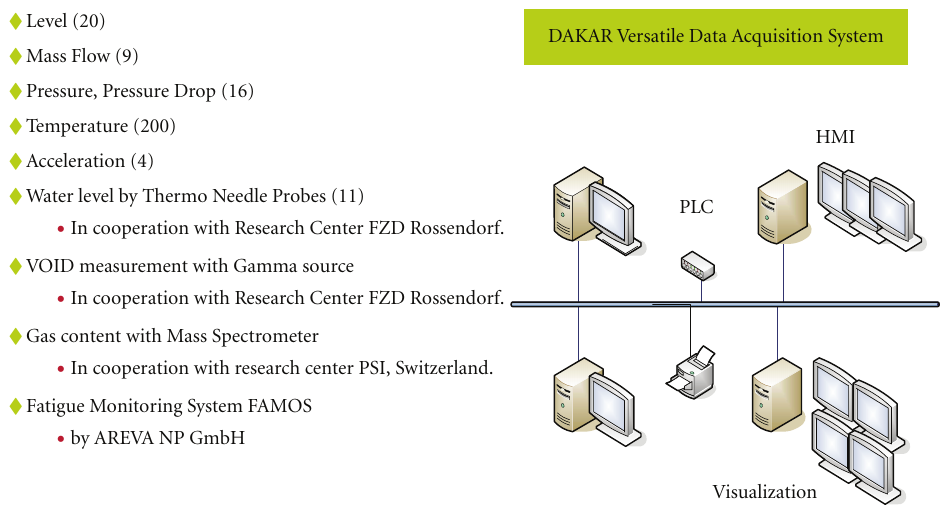
Figure 6: Instrumentation and Data Acquisition